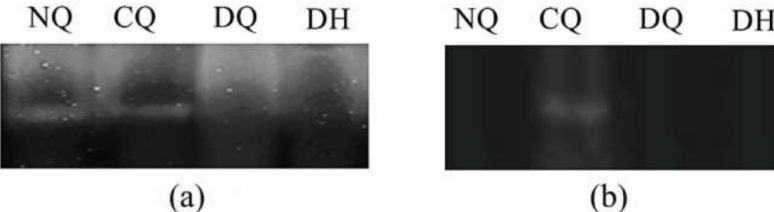
Figure 4. The aldehyde tagged protein labeled using Alexa Fluor 647. ( a ) ST0779 with and without an aldehyde tag; ( b ) BsLA with and without an aldehyde